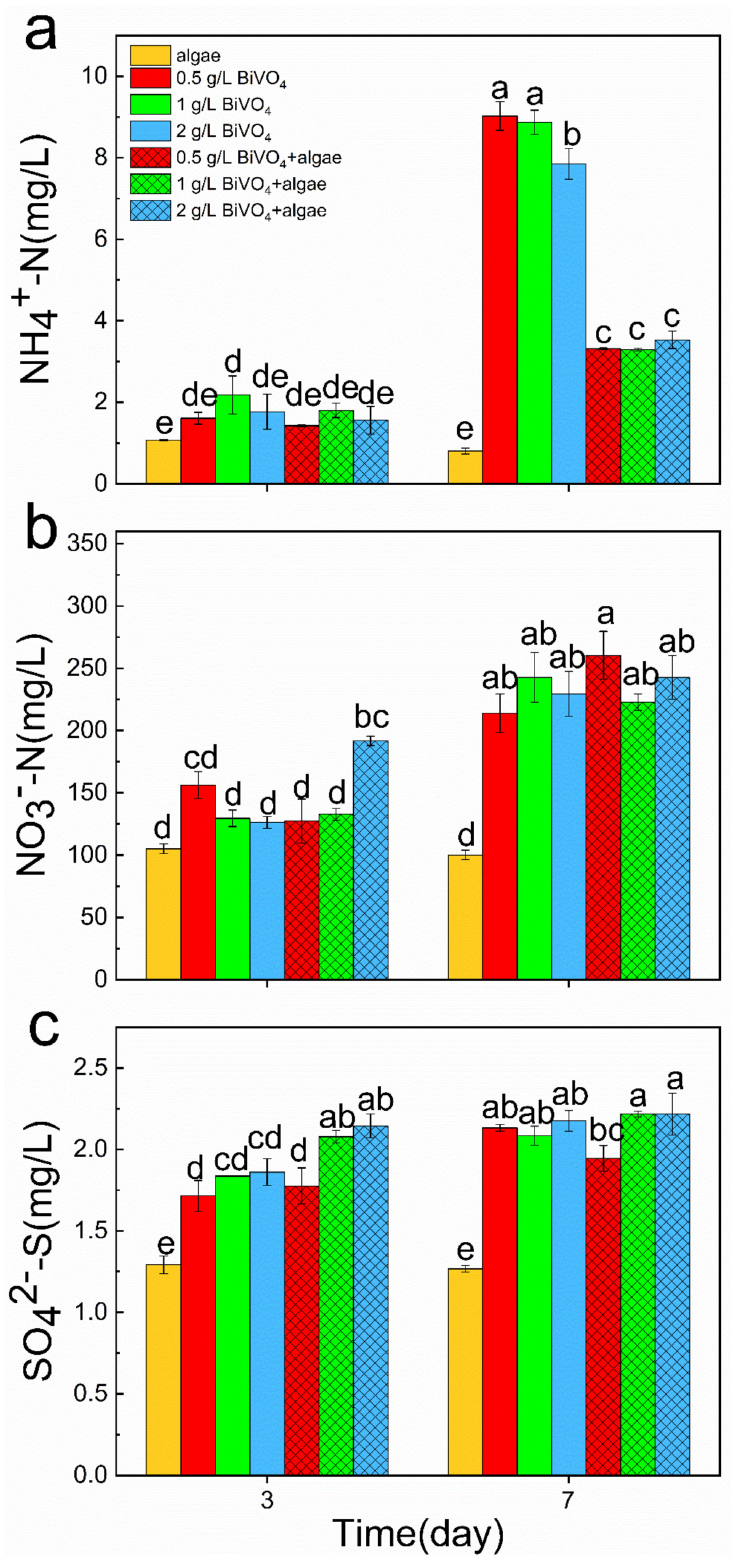
Figure 4. Changes of NH 4 + -N ( a ), NO 3 − -N ( b ), and SO 4 2 − -S ( c ) contents in the treatment group (BiVO 4 -algae) and control groups (algae and BiVO 4 ) during the experiment. Identical letters denote no significant difference ( p